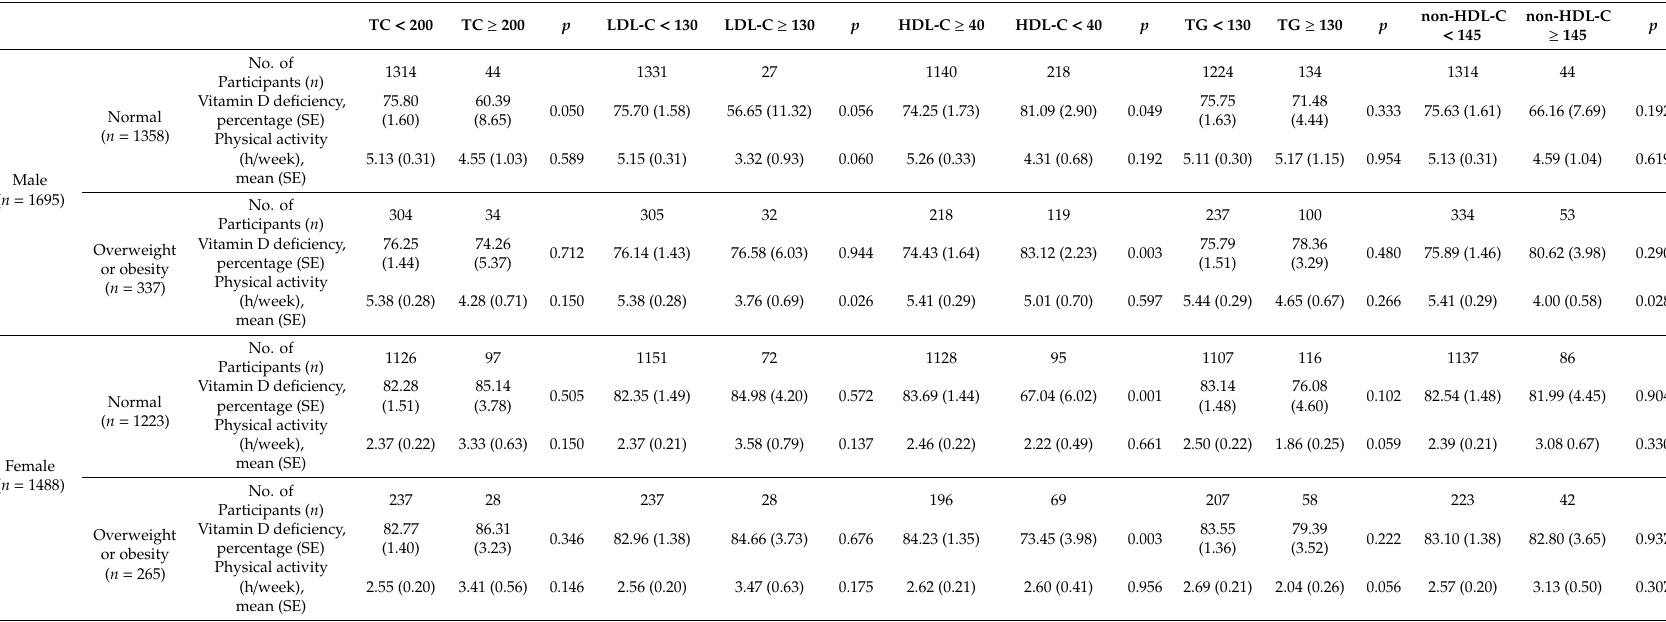
Table 3. Proportion of subjects with vitamin D deficiency and physical activity according to BMI and lipid